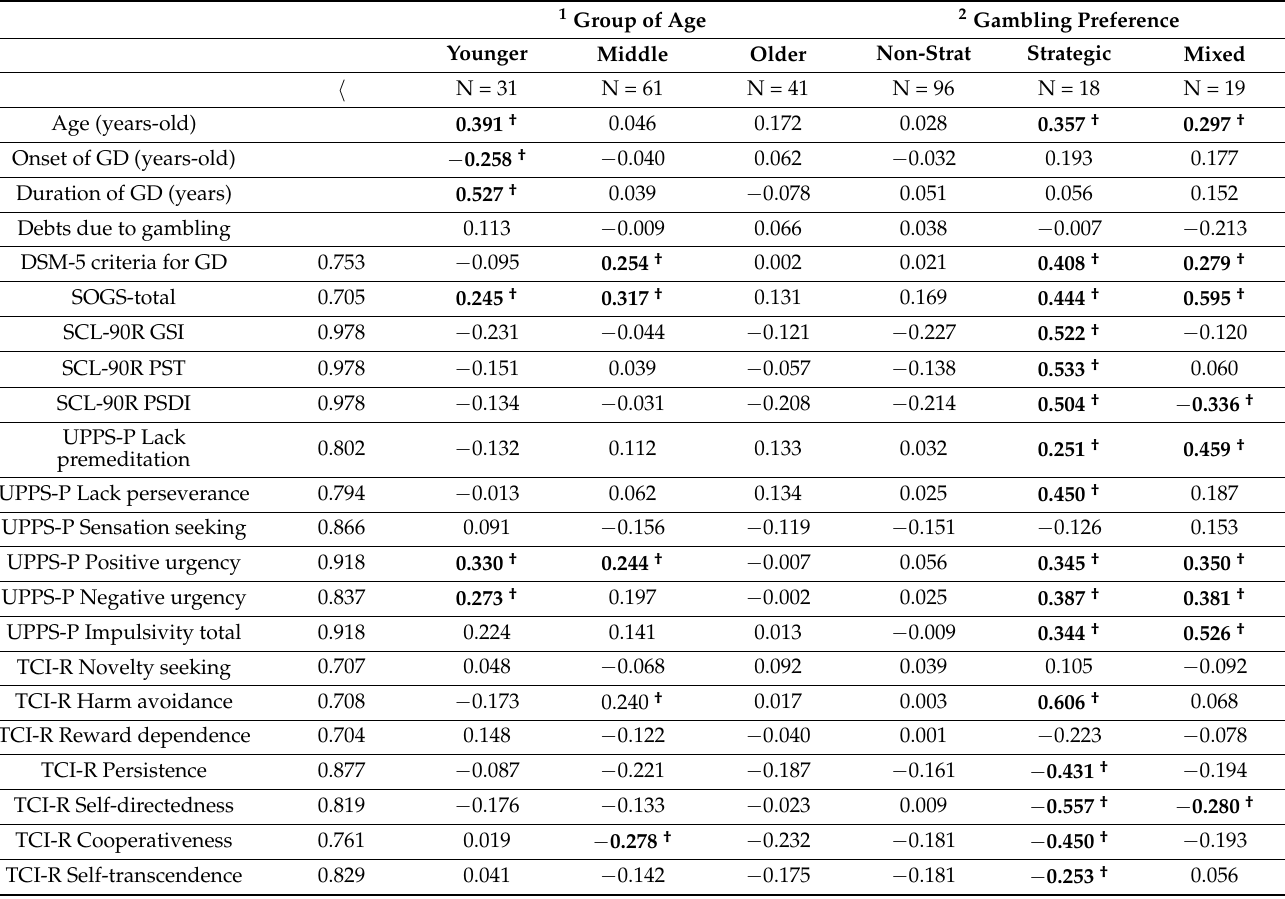
Table 1. Correlations between delay discount rate with the clinical profile at baseline.